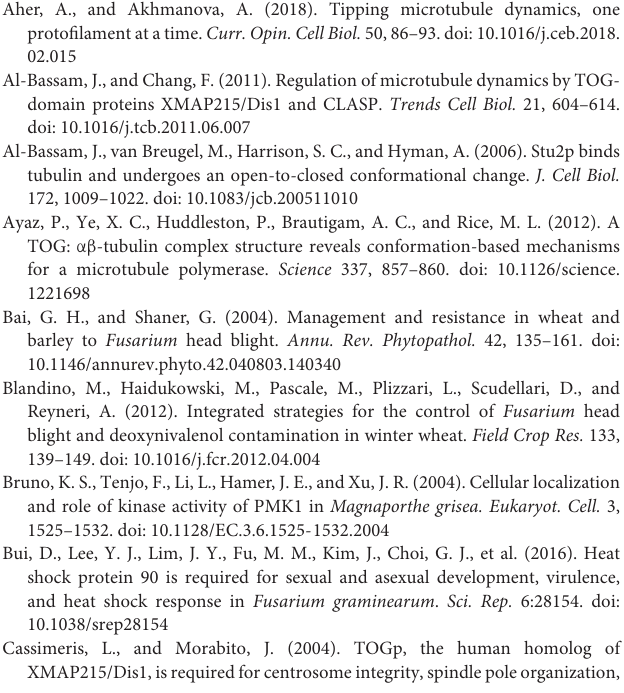
Supplementary Figure 1 | The phylogenetic analysis of Dis1/Stu2/XMAP215 homologs. The phylogenetic tree was generated by MEGA 7.0 software. The whole sequences of Dis1/Stu2/XMAP215 homologs ( Aaspergillus nidulans protein ID: XP_663125.1; Fusarium graminearum protein ID: XP_011319522.1; Neurospora crassa protein ID: XP_956946.3; Saccharomyces cerevisiae protein ID: NP_013146.1; and Schizosaccharomyces pombe protein ID: NP_587785.1) were acquired from the National Center for Biotechnology information website (NCBI, https://www.ncbi.nlm.nih.gov/). Supplementary Figure 2 | Multiple Sequences alignment of C-terminal areas of Stu2 homologs. Multiple sequences ( Aaspergillus nidulans protein ID: XP_663125.1; Fusarium graminearum protein ID: XP_011319522.1; Neurospora crassa protein ID: XP_956946.3; Saccharomyces cerevisiae protein ID: NP_013146.1; and Schizosaccharomyces pombe protein ID: NP_587785.1)